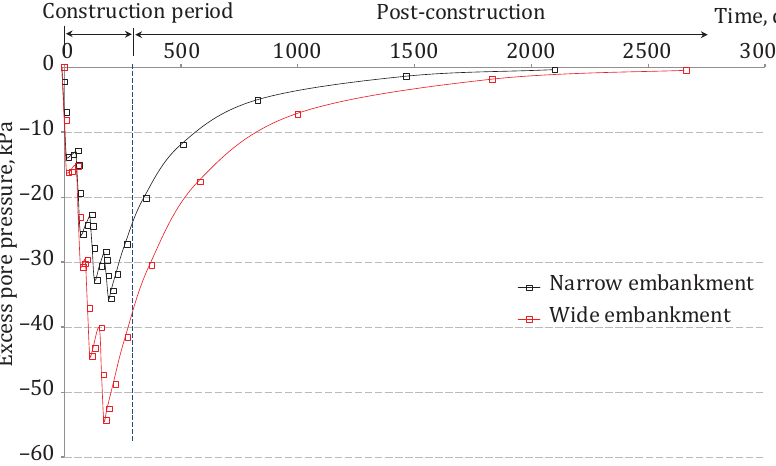
Construction period